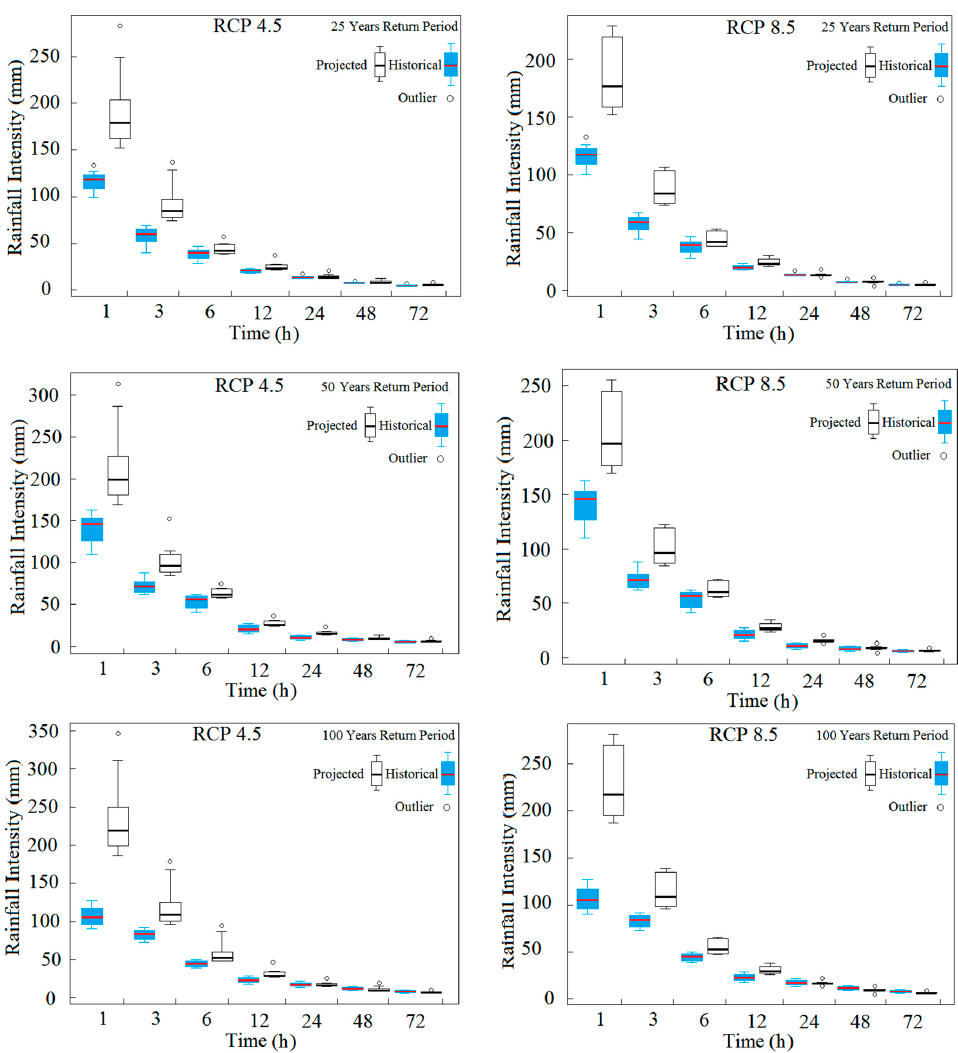
Figure 9. Box plot showing the uncertainty in rainfall intensities for different rainfall durations and return periods (2, 5 and 10 years) at station Kedah under RCP 4.5 and RCP 8.5.